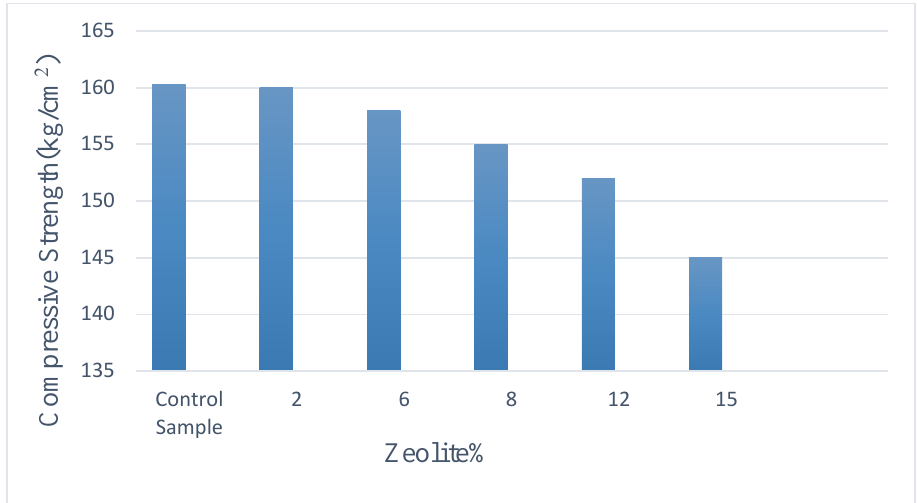
Fig. 3. Concrete strength with different percentages of Zeolite with 400 grade cement at 7 days old concrete.